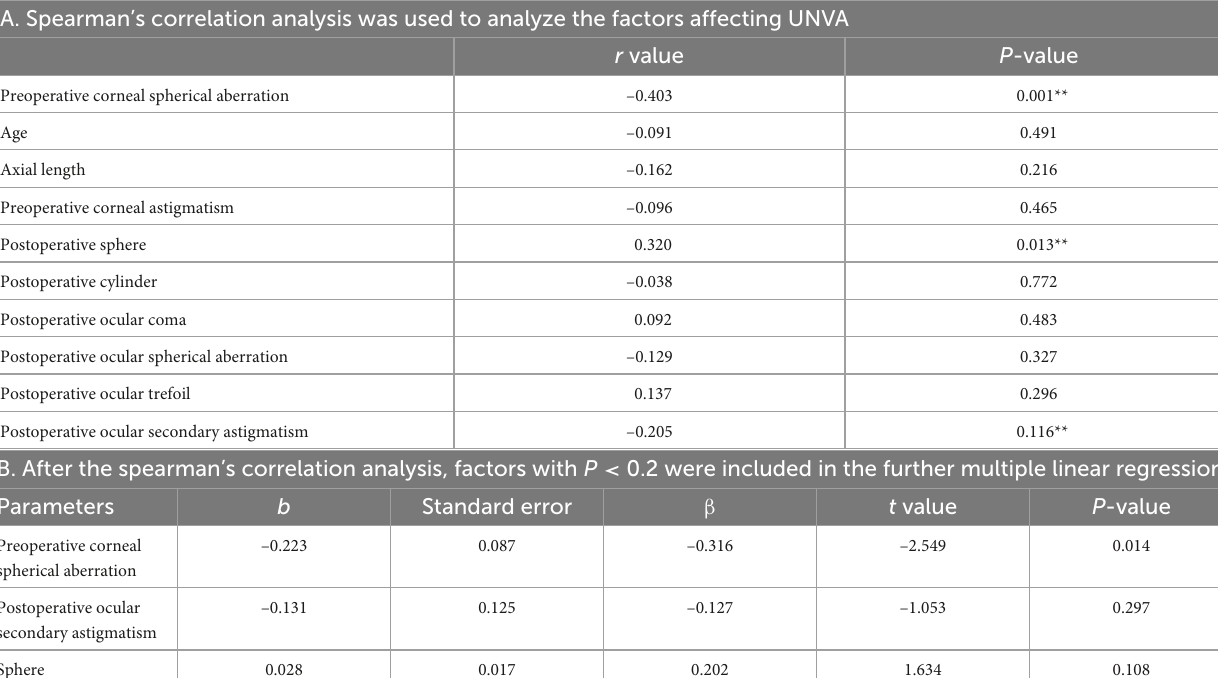
TABLE 3 Spearman correlation (A) and multiple linear regression (B) were used to analyze the impact of preoperative corneal spherical aberration, age, axial length, corneal astigmatism, postoperative sphere, cylinder, ocular coma, trefoil, and secondary astigmatism on UNVA. A. Spearman’s correlation analysis was used to analyze the factors affecting